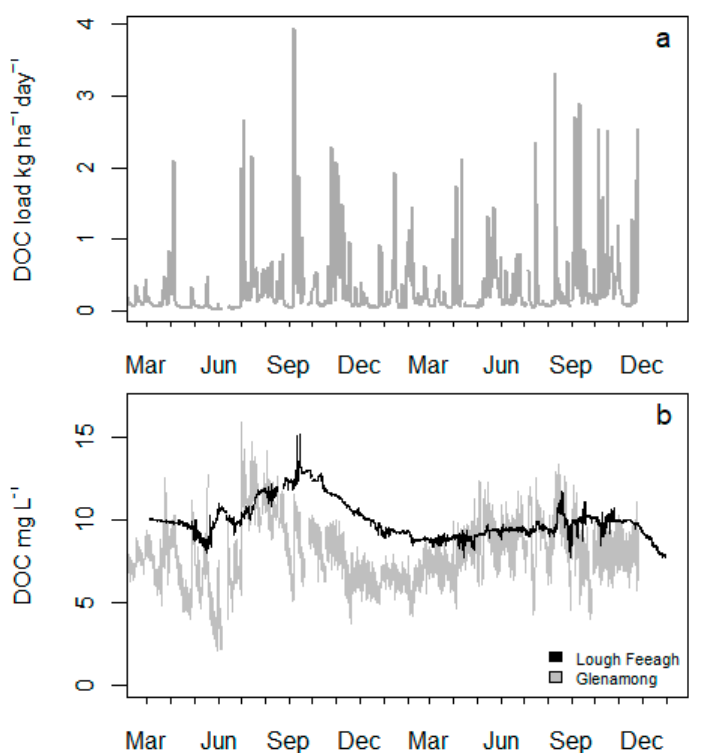
Figure 7. ( a ) Estimated daily DOC loading per hectare to Lough Feeagh based on the data for the Glenamong sub-catchment March 2010 to December 2011; ( b ) estimated hourly DOC concentration in the Glenamong River (grey) and in Lough Feeagh (black).